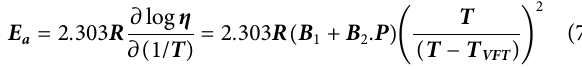
Frontiers in Earth Science |